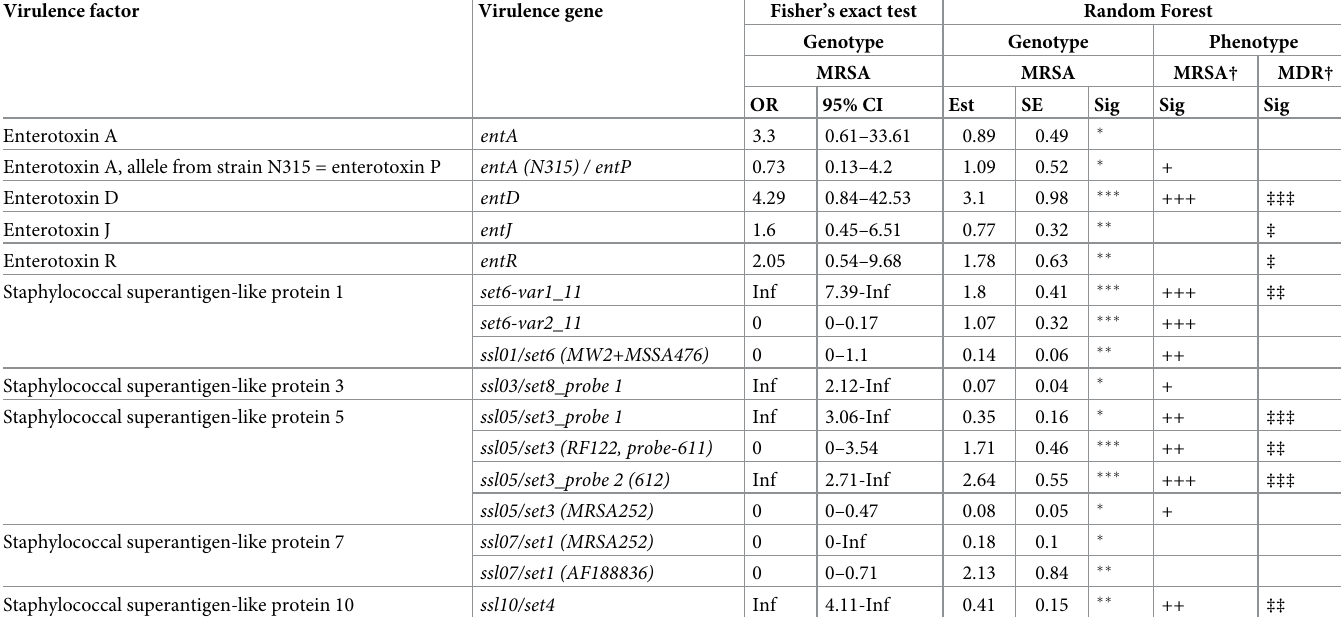
Table 2. Informative virulence genes for predicting methicillin and multidrug resistance profiles.